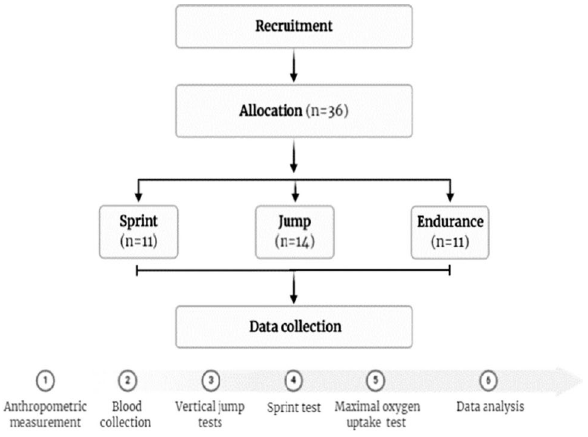
Figure 1 - Illustration of the experimental